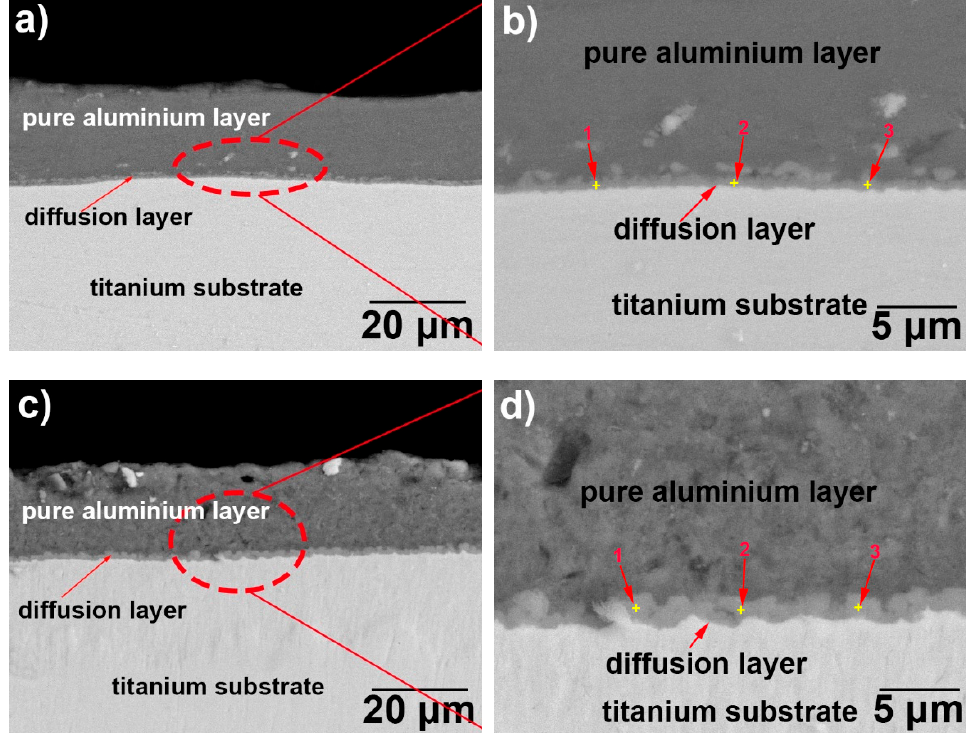
Figure 3. Cross ‐ section of BSE morphologies of hot ‐ dip aluminised coatings on TA2 substrate: ( a ) and Figure 3. Cross-section of BSE morphologies of hot-dip aluminised coatings on TA2 substrate: ( a , b ) T-1 ( b ) T ‐ 1 and ( c ) and ( d ) T ‐ 2 samples. and ( c , d ) T-2